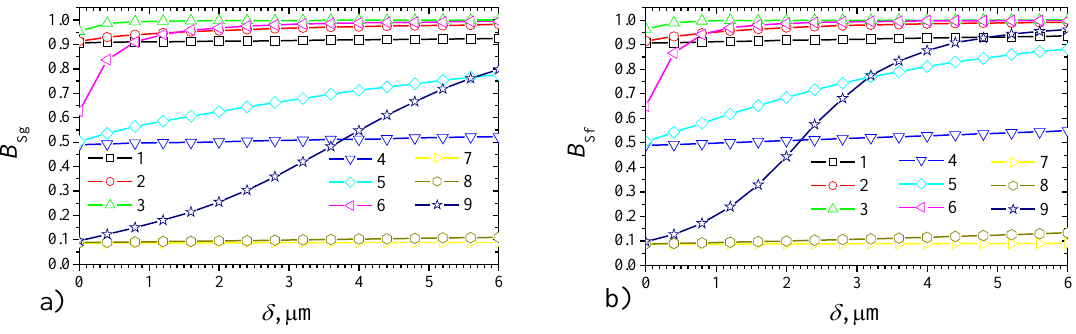
Figure 4 . The normalized biosensor sensitivity vs. the thickness δ of the outer membrane in the cases of plate − gap (a) and flat (b) biosensors. The parameters and notations are the same as in Fig.